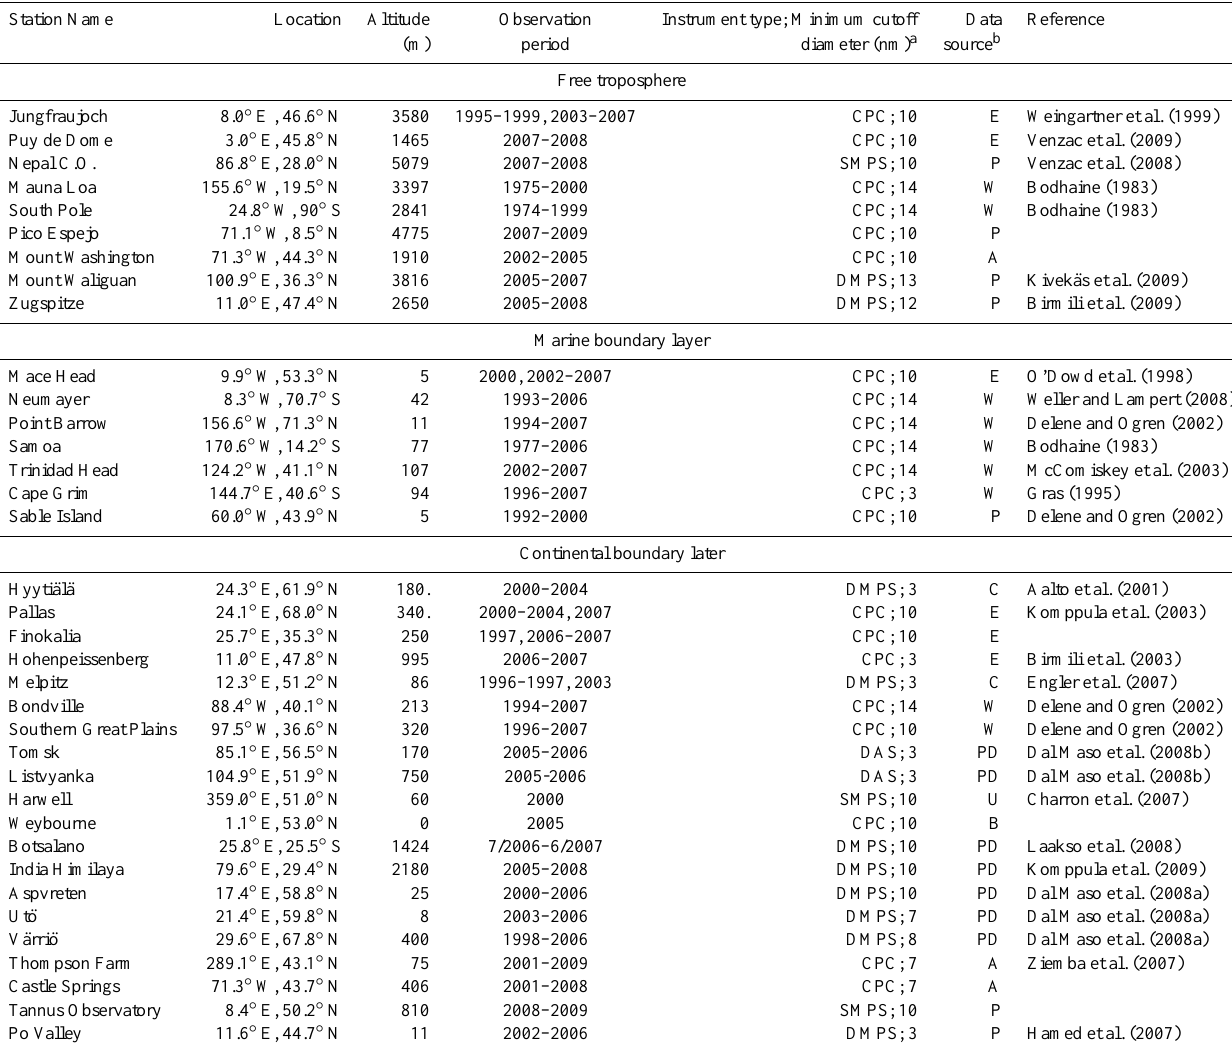
Table 2. Observation sites used in this